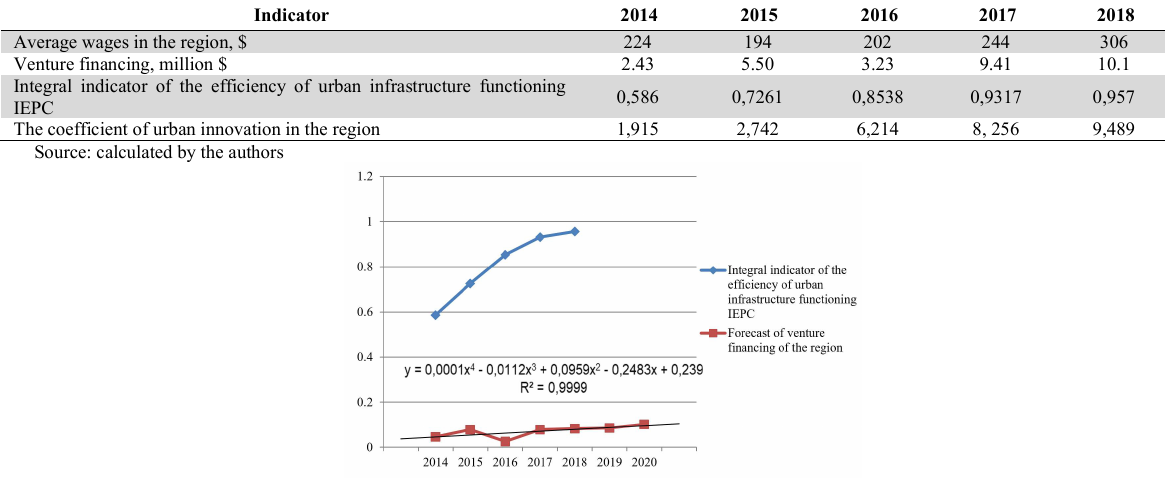
Fig. 6. Multiplicative effect of urban innovations in the region Source: formed by the